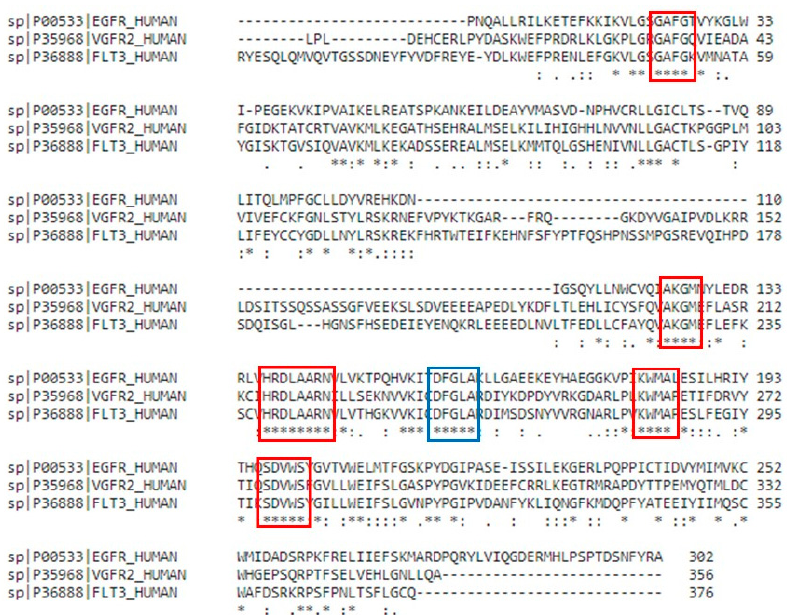
Figure 3. Multiple sequence alignment of PDB sequences from EGFR, VEGFR-2 and FLT-3 protein kinase used for docking study (red boxes implicate cluster of conserved residues where blue box represents activation loop with DFG motif). Here, asterisk “*” represents conserved residues in all three kinase domains; colon “:” shows at least two residues are conserved; and period “.” indicates non-conserved residues.